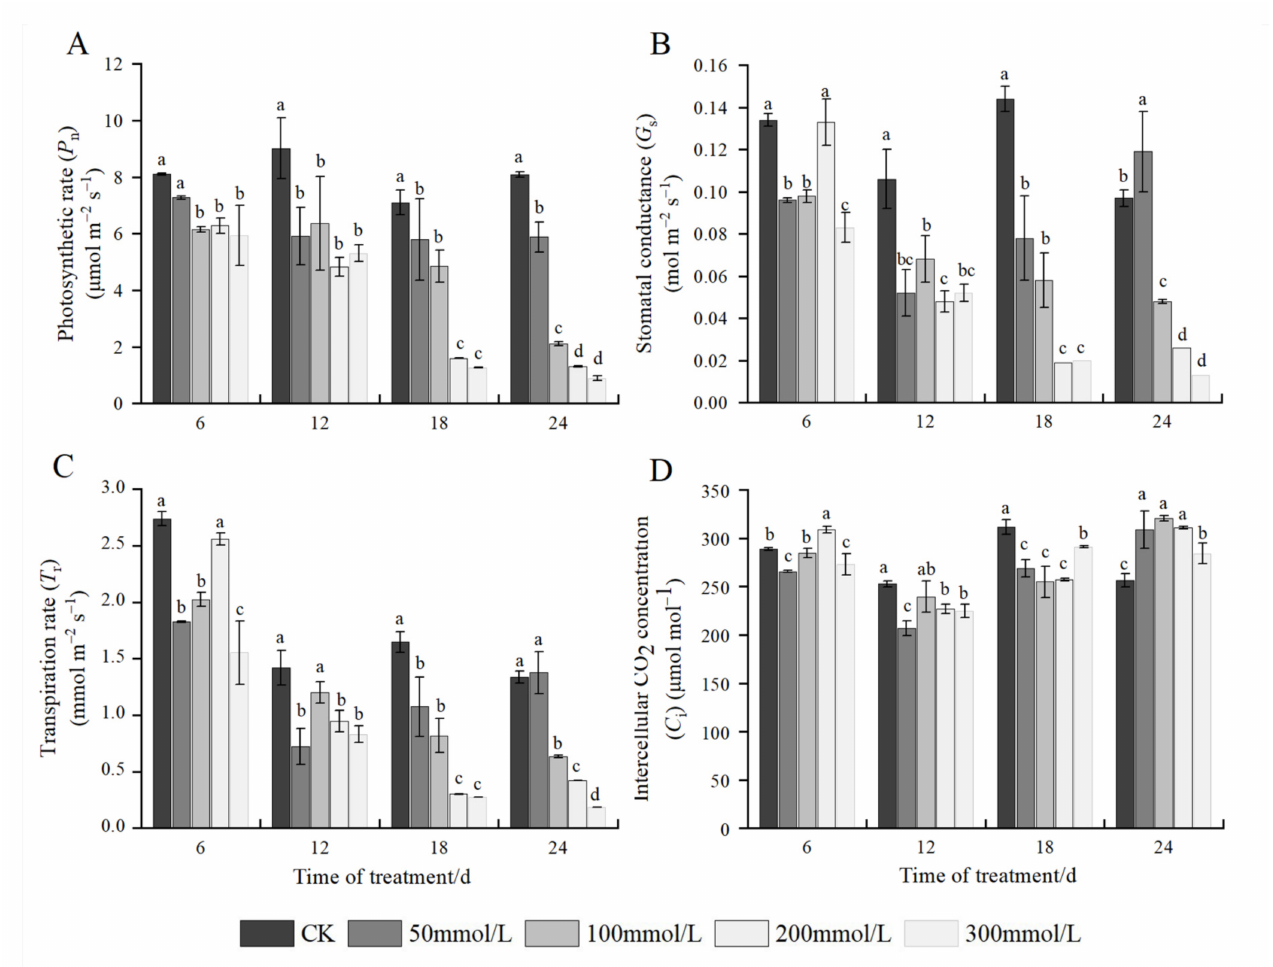
Figure 2. Effect of salt stress on the photosynthetic parameters of J. microcarpa L. seedlings. ( A ) Photosynthetic rate ( P n ), ( B ) stomatal conductance ( G s ), ( C ) transpiration ( T r ), and ( D ) inter- cellular CO 2 concentration ( C i ) in the leaves. Error bars indicate the SD of treatment means. Different letters on the bars indicate significant differences among the treatments ( p <